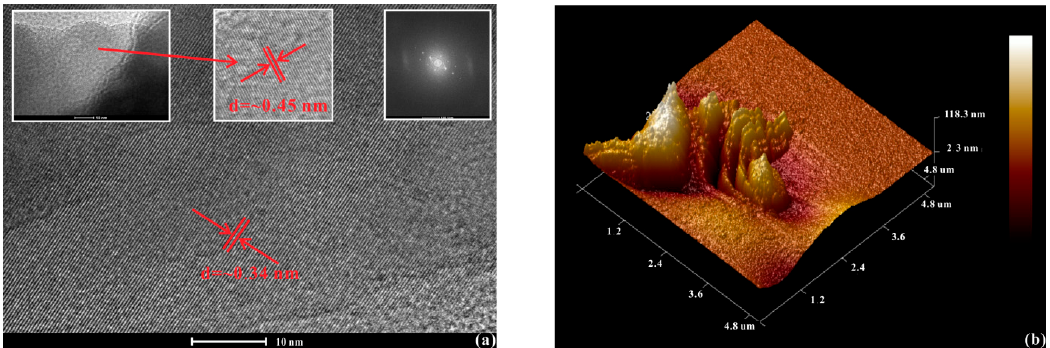
Figure 7. ( a ) The high-resolution transmission electron microscopy (HRTEM) images of decompressed orpiment from 44.0 GPa. Inset: the left one is a HRTEM image of the initial sample, the right one is a cross-sectional selected-area electron diffraction pattern by HRTEM for the decompressed orpiment. ( b ) The atomic force microscopy (AFM) image of orpiment upon decompression from 44.0 GPa.